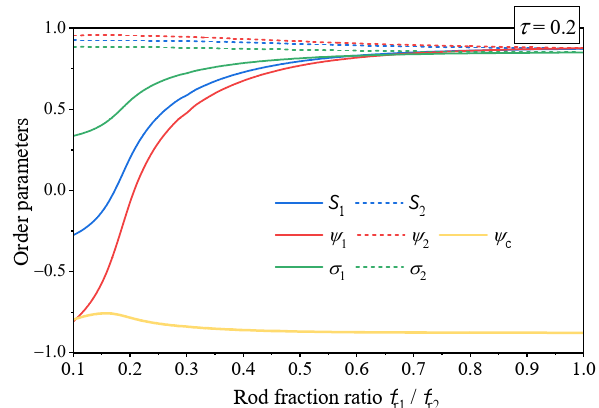
Figure 2. Order parameters of lamellar phase of the asymmetric rod-coil-rod triblock copolymer as functions of the rod fraction ratio f r 1 / f r 2 at a constant dimensionless temperature τ = 0.2. All other model parameters are the same as in Figure